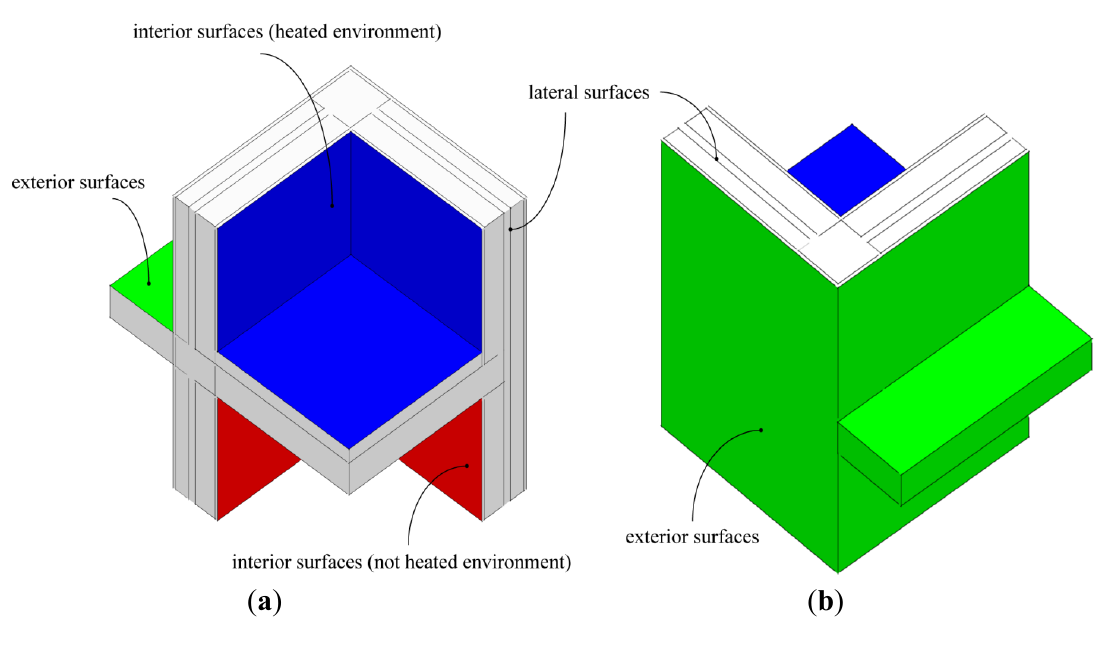
Figure 6. Longitudinal and transverse sections of the